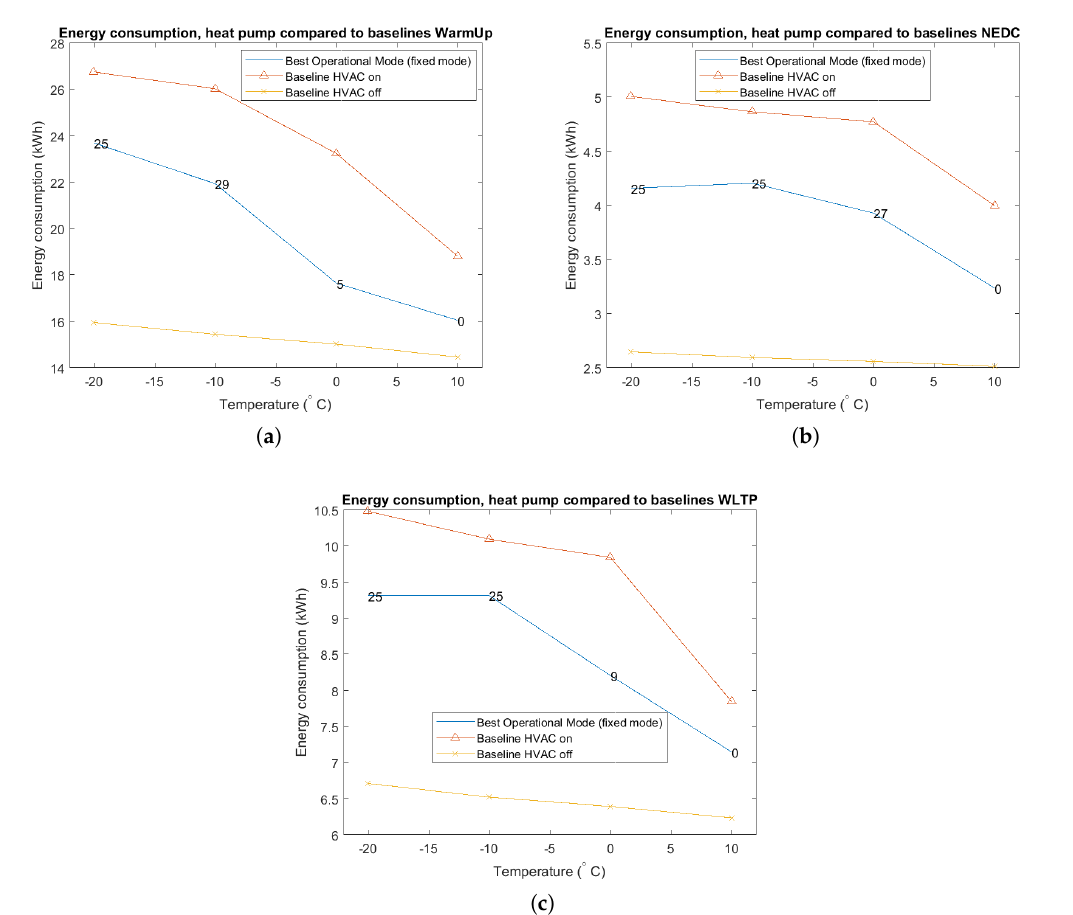
Figure 6. Comparison of total electrical energy consumption over WarmUp, NEDC and WLTP (( a – c ) respectively) of the best single operational mode during each scenario to the baseline results of HVAC on and HVAC